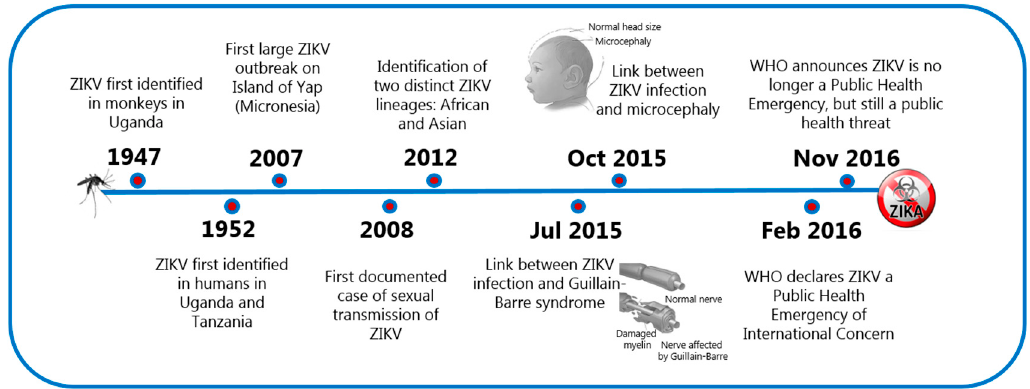
Figure 1. The chronology of the most crucial events of the Zika virus (ZIKV) infection. Images adapted under license from Shutterstock.com.